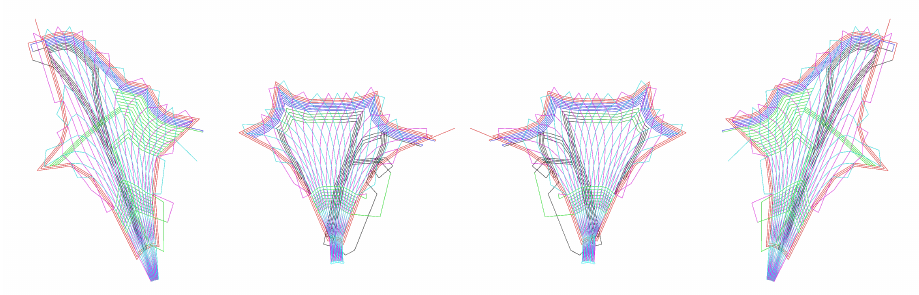
Figure 24. CAD drawings of unrolled geometries for TFP production. One for each leg in the chair.